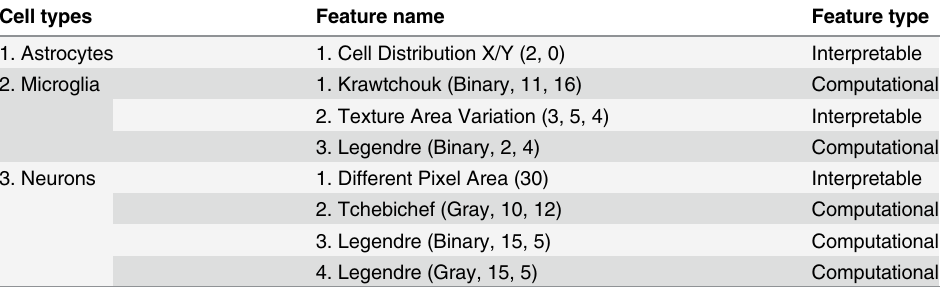
Table 6. Typical feature sets using the feature selection algorithm IBCGA from 30 training